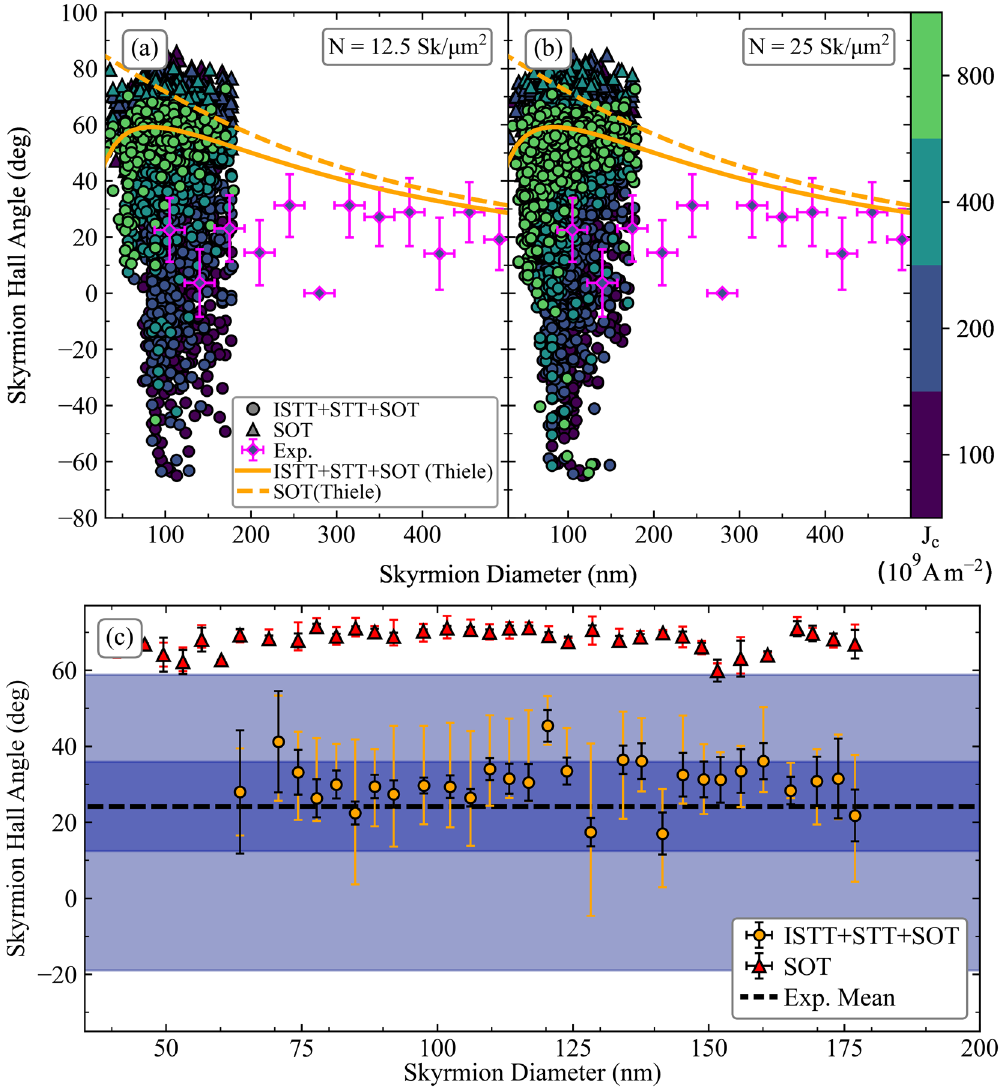
Figure 3. SkHA-diameter dependence for skyrmion collections with ( a ) N = 12.5 Sk/µm 2 , and ( b ) N = 25 Sk/ µm 2 . The solid disks and triangles represent results for ISTT + STT + SOT, and SOT-only respectively, for a corresponding applied current density indicated by the colour bar. Magenta outlined diamonds represent the experimental results. The orange solid and dashed lines represent the Thiele equation solution for spin torque contributions ISTT + STT + SOT, and SOT-only respectively, with a damping value α = 0.1. ( c ) Detail at the average current density used in experiments, J C = 2 × 10 11 A/m 2 . The dashed horizontal line is the mean experimental SkHA, with the inner blue horizontal band showing standard error on the mean, and lighter blue outer band showing the spread (quartile 1 to quartile 3). This is compared to the solid disks showing modelling results with ISTT + STT + SOT, and solid triangles for SOT-only, also at J C = 2 × 10 11 A/m 2 (smaller error bars are standard error on the mean, and larger error bars are the